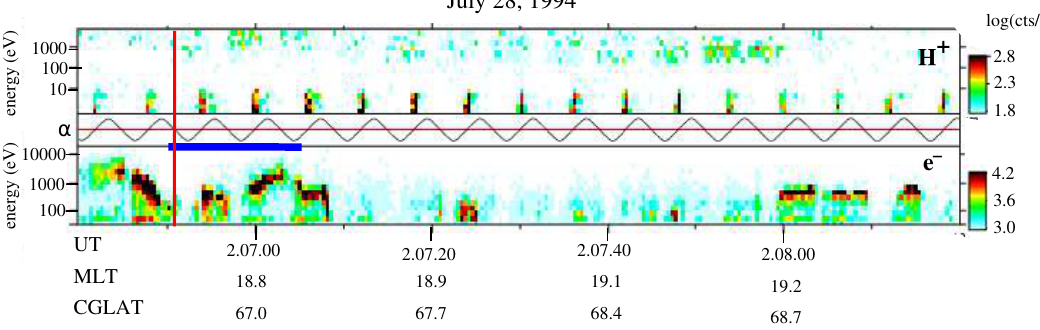
Fig. 7. Particle observations from 28 July 1994. The time interval corresponding to the wave data presented in Fig. 3 is indicated with a thick red line. The top panel shows count rates of H + versus time, while the corresponding pitch angles are displayed in the middle panel. Since the data are recorded in the Northern Hemisphere a pitch angle of 0 ◦ (i.e. parallel to the ambient magnetic field) corresponds to downgoing particles. The bottom panel displays count rates of downgoing electrons. Irregular density variations with enhancements in the wave E - and B -fields are found at the edge of an inverted-V structure.